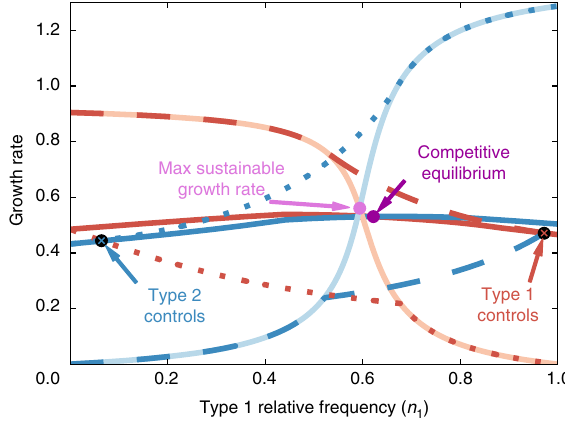
Fig. 5 Different types of equilibria and the growth cost of control. The steady-state growth rate of cells of type 1 (red) and type 2 (blue) under four different scenarios: each type maximizing its own growth (dark solid lines), both types maximizing the growth of cells of type 1 (dashed), both types maximizing the growth of cells of type 2 (dotted), and perfect coordination, where each cell type produces only a single metabolite and the population achieves the maximum sustainable growth rate (light solid lines). The production ef fi ciencies used in this example are a A ,1 = a B ,1 = 1, a = 0.67, and a = 1.49. The resulting population dynamic equilibria are A ,2 B ,2 marked. The growth rate of the competitive equilibrium is closer to the maximum sustainable growth rate than either equilibria reached when a single cell type is in